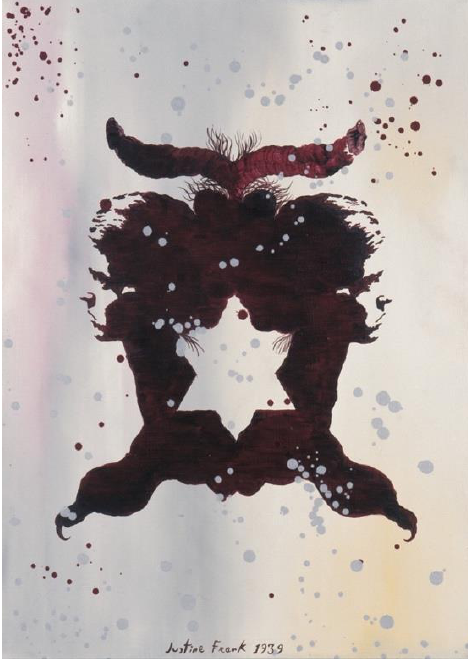
Figure 20. Justine Frank, Frank Coat of Arms , 1939, oil on canvas, 70 × 50 cm. Courtesy of the artist.